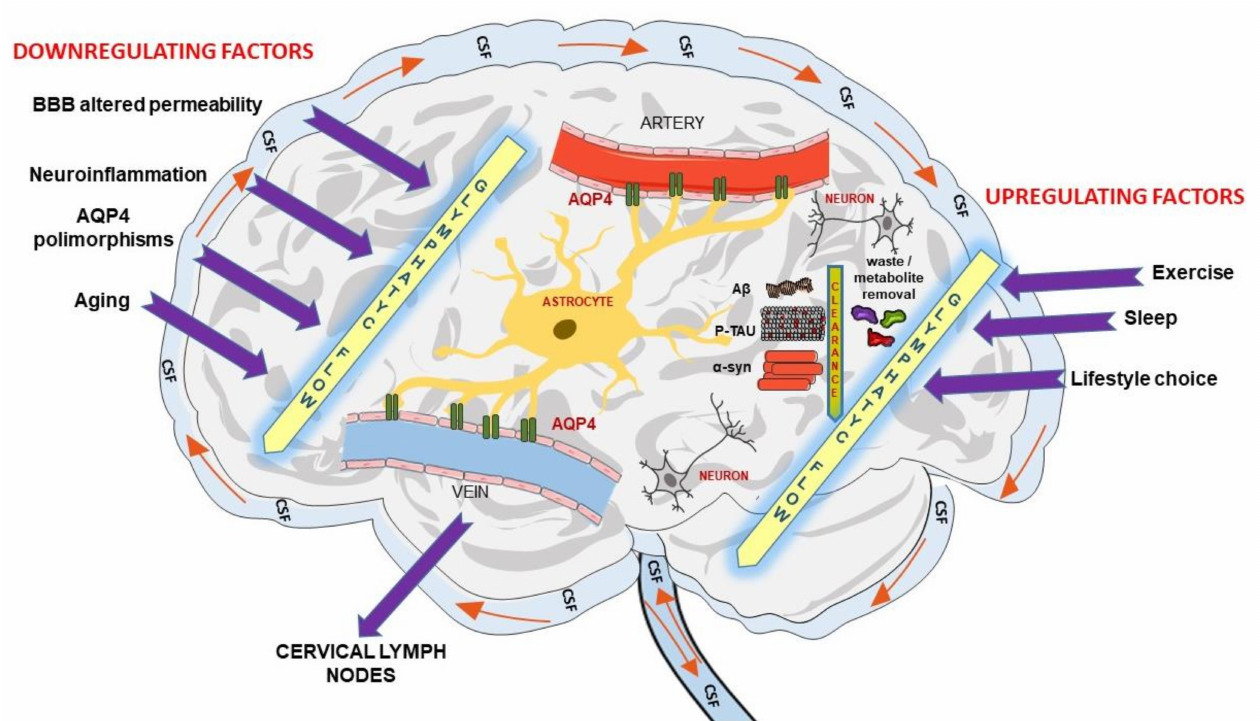
Figure 1. Schematic figure of the current model of the Glymphatic